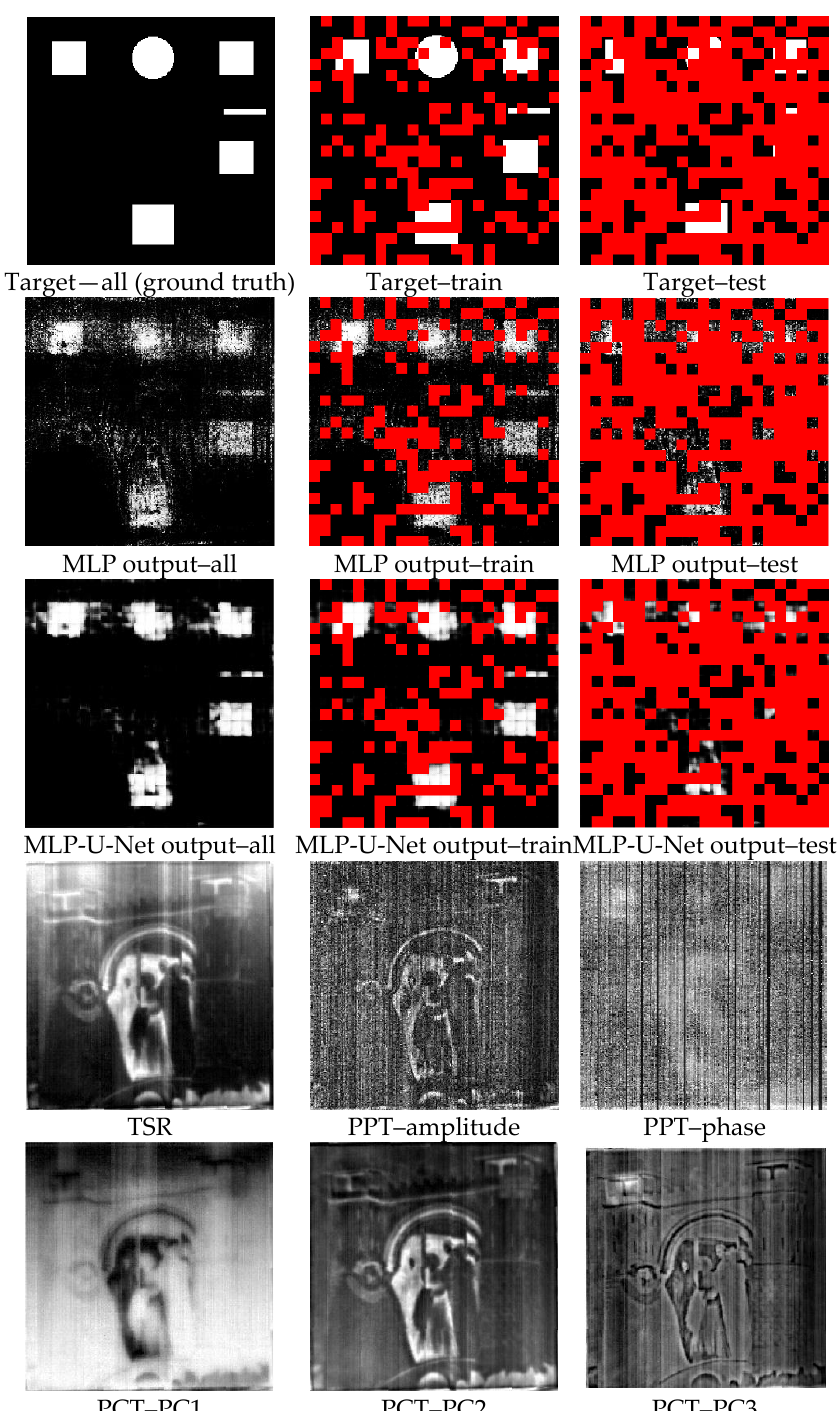
Figure 4. Results of MLP based on only temporal information (the 2nd row), MLP-U-Net based on both temporal and spatial information (the 3rd row), and the well-known algorithms of TSR, PPT, and PCT (the 4th and 5th rows) compared to the ground truth image (the 1st row) for the first dataset. The red color for the first three rows represents the unused pixels for training or test.